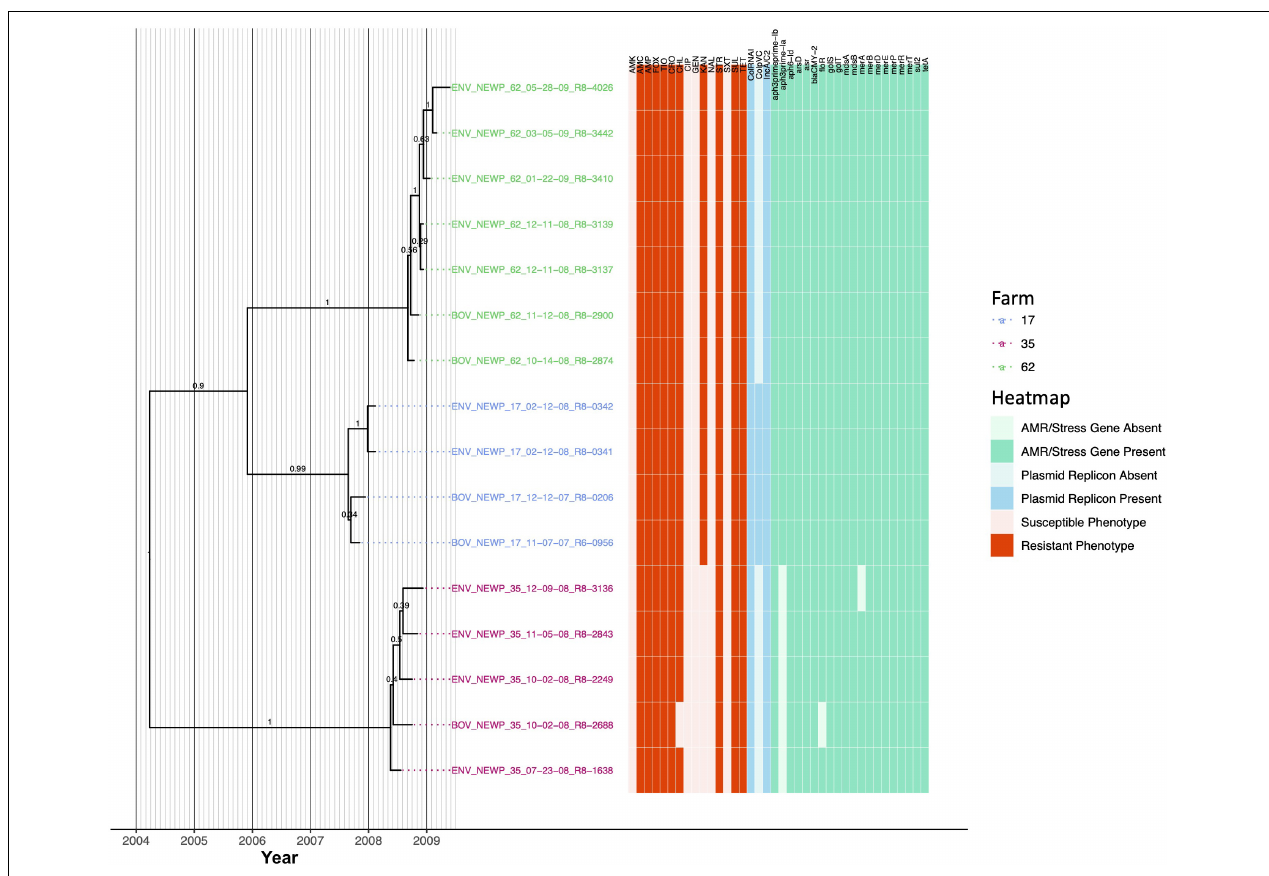
FIGURE 9 | Rooted, time-scaled maximum clade credibility (MCC) phylogeny constructed using core SNPs identified among 16 Salmonella Newport genomes isolated from subclinical bovine sources and the surrounding bovine farm environment. Tip label colors denote the ID of the farm from which each strain was isolated. Branch labels denote posterior probabilities of branch support. Time in years is plotted along the X -axis, and branch lengths are reported in years. The heatmap to the right of the phylogeny denotes (i) the susceptible-intermediate-resistant (SIR) classification of each isolate for each of 15 antimicrobials (obtained using phenotypic testing and NARMS breakpoints; orange); (ii) presence and absence of plasmid replicons (detected using ABRicate/PlasmidFinder and minimum nucleotide identity and coverage thresholds of 80 and 60%, respectively; blue); (iii) presence and absence of antimicrobial resistance (AMR) and stress response genes (identified using AMRFinderPlus and default parameters; green). Core SNPs were identified using Snippy. The phylogeny was constructed using the results of ten independent runs using a relaxed lognormal clock model, the Standard_TPM1 nucleotide substitution model, and the Coalescent Bayesian Skyline population model implemented in BEAST version 2.5.1, with 10% burn-in applied to each run. LogCombiner-2 was used to combine BEAST 2 log files, and TreeAnnotator-2 was used to construct the phylogeny using common ancestor node heights. Abbreviations for the 15 antimicrobials are: AMK, amikacin; AMC, amoxicillin-clavulanic acid; AMP, ampicillin; FOX, cefoxitin; TIO, ceftiofur; CRO, ceftriaxone; CHL, chloramphenicol; CIP, ciprofloxacin; GEN, gentamicin; KAN, kanamycin; NAL, nalidixic acid; STR, streptomycin; SXT, sulfamethoxazole-trimethoprim; SUL, sulfisoxazole; TET, tetracycline.